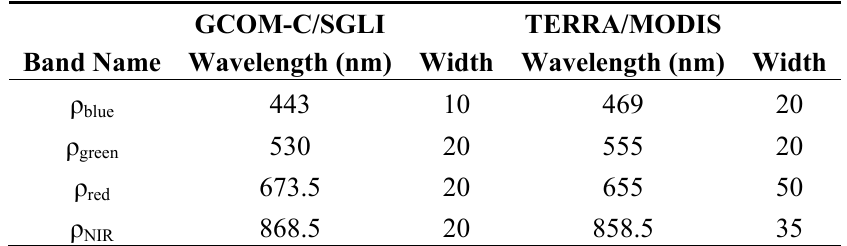
Table 1. Global Change Observation Mission-Climate (GCOM-C)/ second-generation global imager (SGLI) and TERRA/MODIS spectral bands (showing only bands 1 to